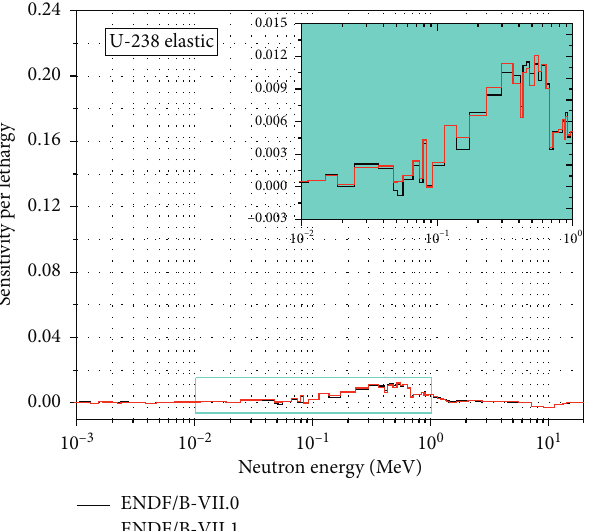
Figure 10: Energy-dependent sensitivities of k